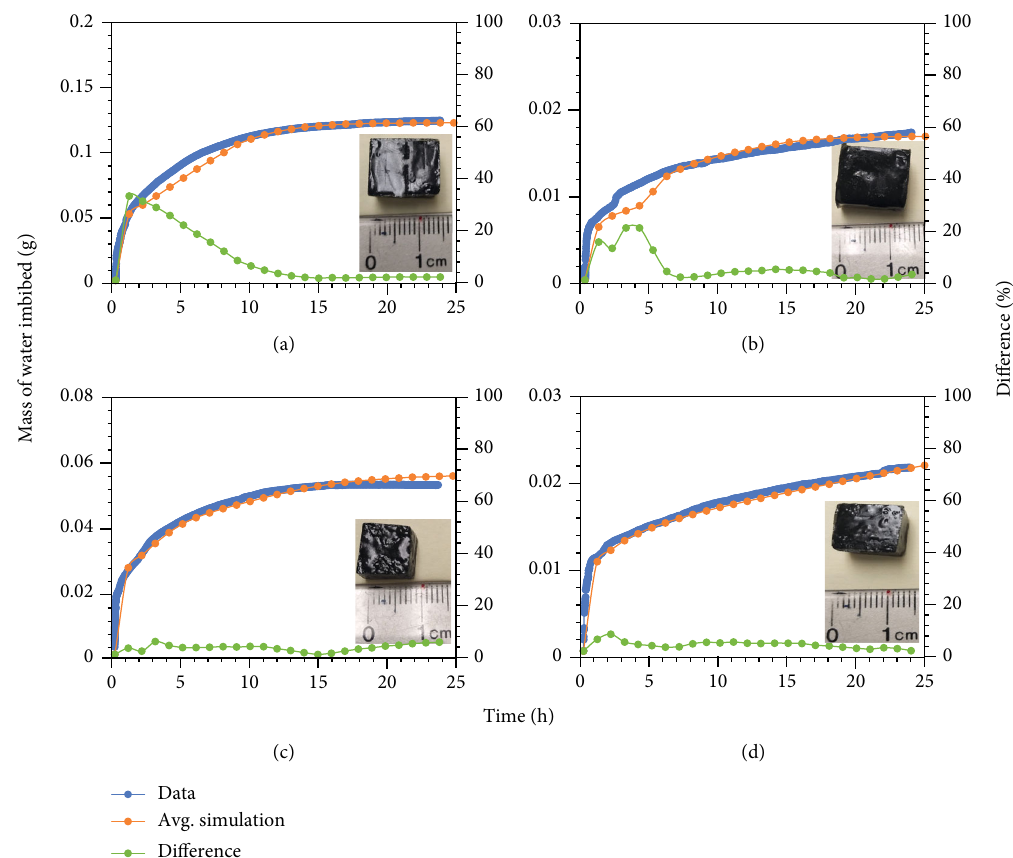
Figure 14: Comparison of imbibed water mass over time in Barnett Shale samples: (a) P -direction fractures, (b) T -direction fractures, (c) P -direction matrix, and (d) T -direction